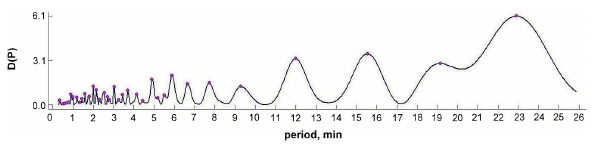
Figure 9. Periodogram for 99995 object, August 12,